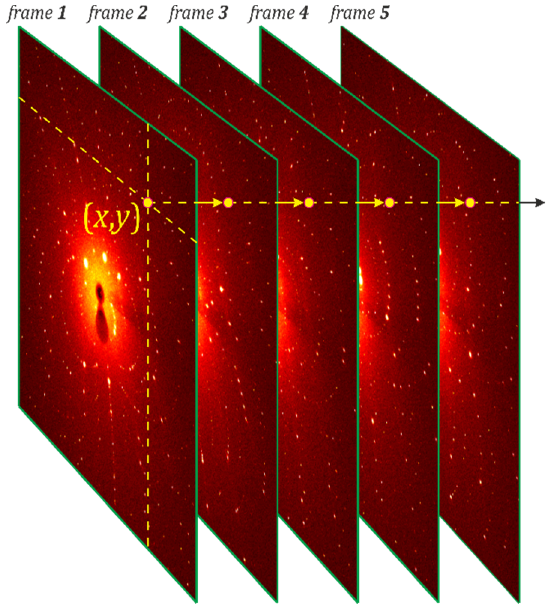
Figure 4. The idea behind the method: intensity of a selected pixel ( x , y ) is analysed vs. frame number. The procedure is repeated for every pixel on the detector surface. Figure reproduced with permission of the International Union of Crystallography from Szarejko et al.